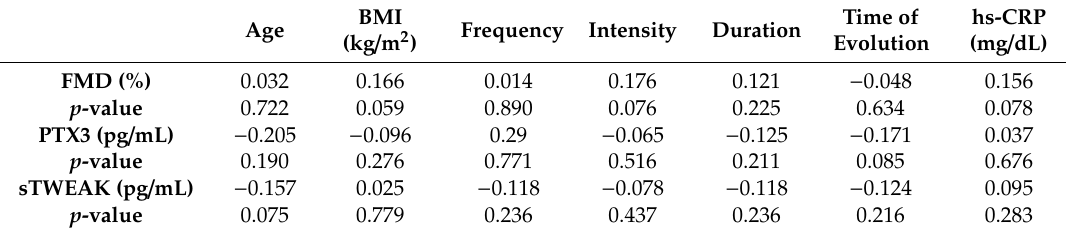
Figure 2. Scatter plots showing correlations between flow-mediated dilation (FMD) (%) and: ( A ) pentraxin 3 (PTX3) (pg / mL); ( B ) soluble tumour necrosis factor-like weak inducer of apoptosis (sTWEAK) (pg / mL). Table 2. Correlations between flow-mediated dilation, clinical and laboratory parameters.